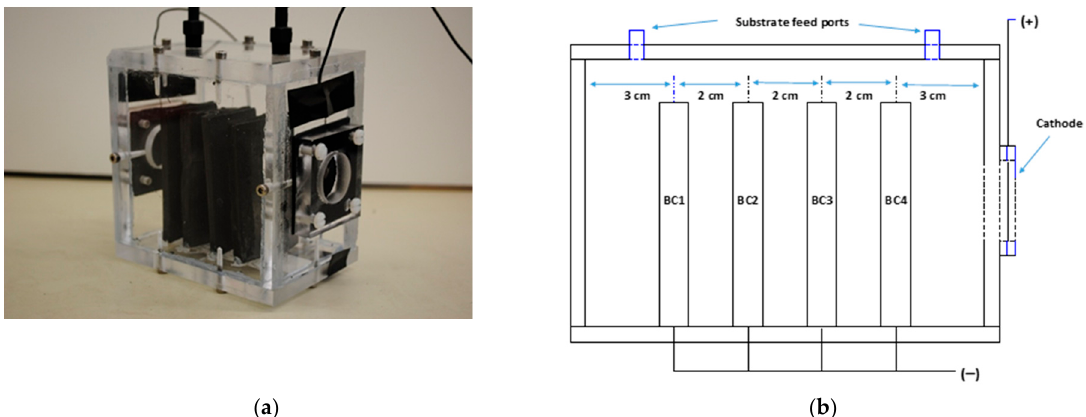
Figure 1. Single-chamber air-cathode MFC with a Pt-coated carbon cloth cathode and bam-boo charcoal (BC) anode: ( a ) photo; ( b ) positioning of bamboo charcoal plates.